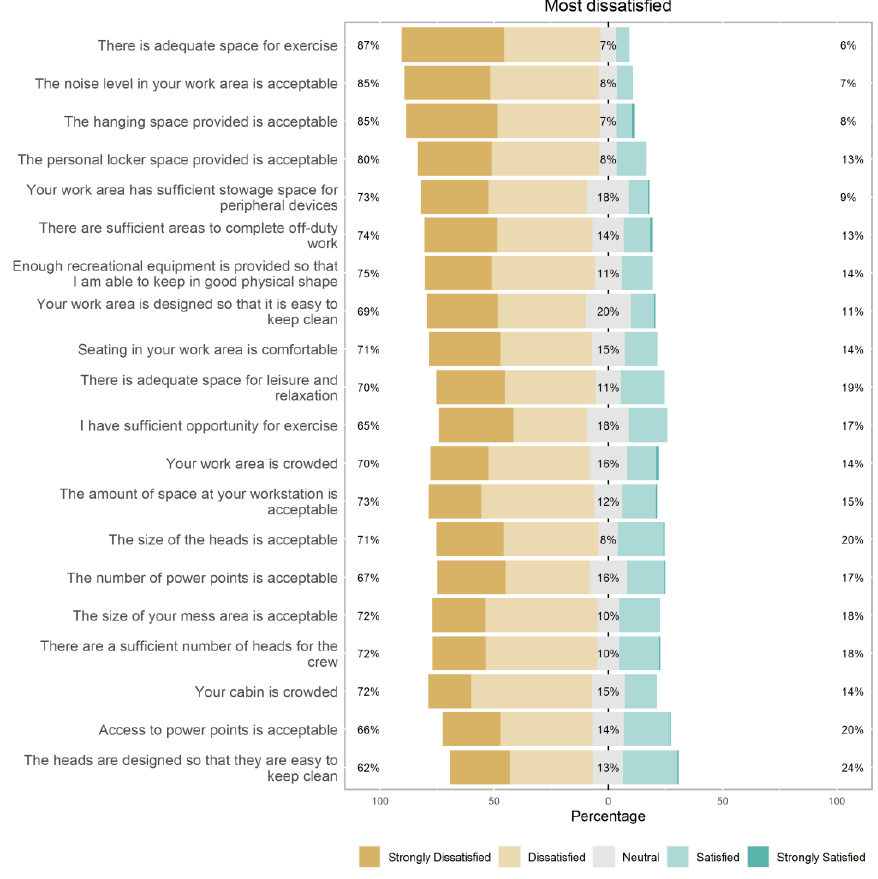
Figure 2. Items with the highest (top) mean dissatisfaction ratings. Note some items have been reverse coded to reflect low to high satisfaction. Values reflect (left to right) the percent of combined strongly dissatisfied and dissatisfied responses, percent of neutral responses, and percent of combined satisfied and strongly satisfied responses.